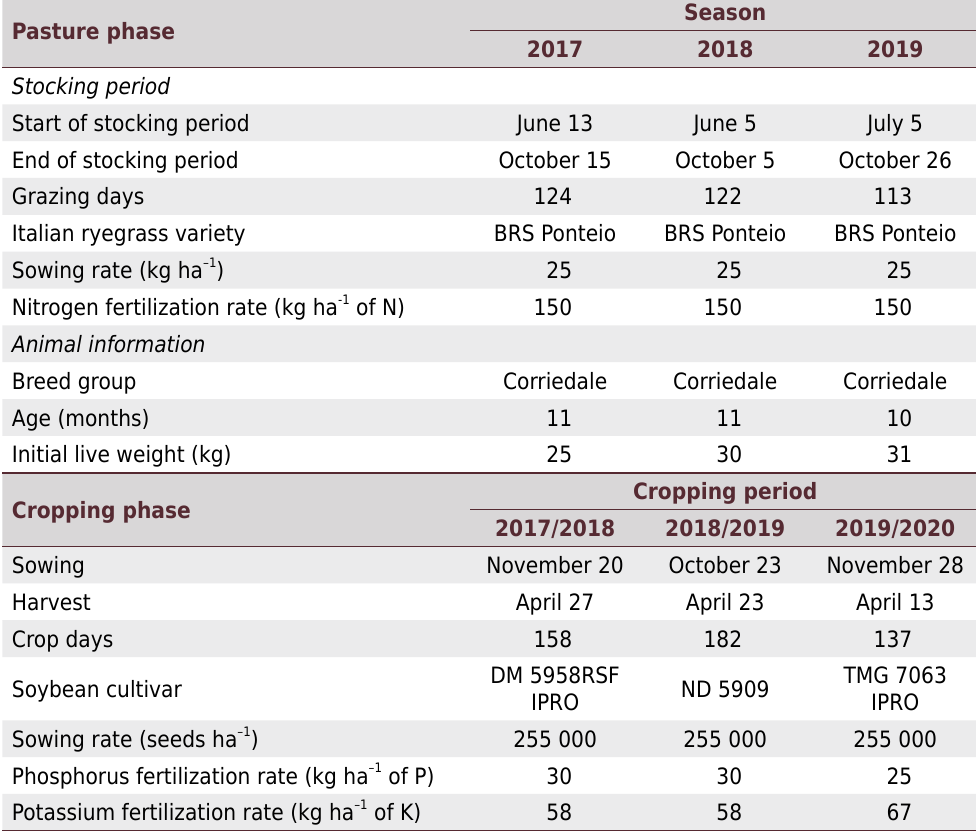
Table 2. Summary of the pasture and cropping phases in the three years of the experiment Pasture